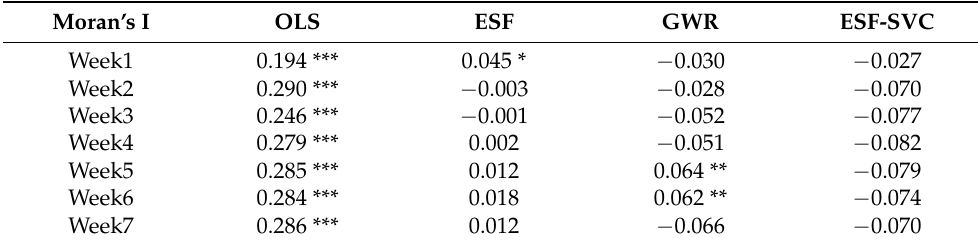
Table 12. Moran’s I values for model residuals in mainland China. Moran’s I OLS ESF GWR ESF-SVC